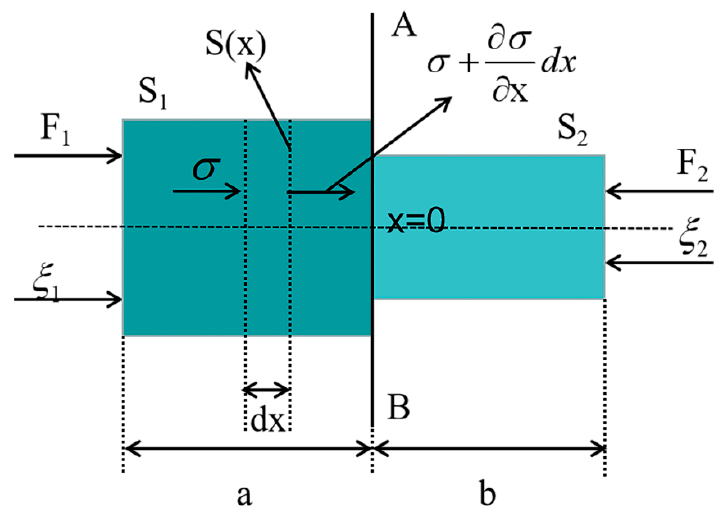
Figure 4. Structural schematic of the stepped ultrasonic horn.